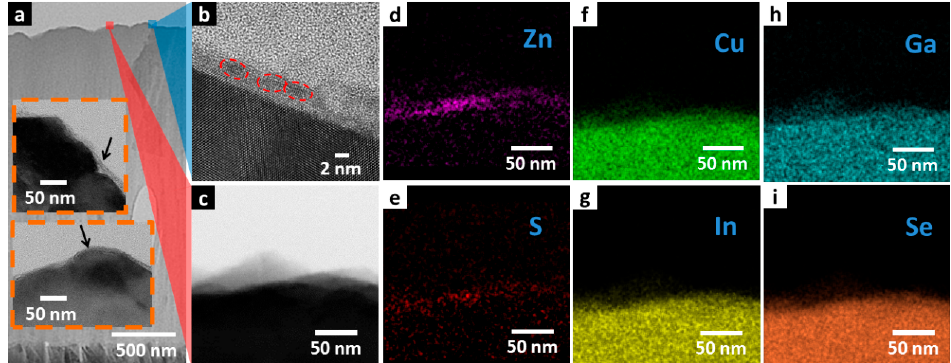
Figure 5. ( a ) TEM overview image of CIGS absorber layer capped by the ZnS NPs layer. Insets show magnified view at ZnS NPs/CIGS interface. ( b ) TEM image of ZnS NPs/CIGS pn junction magnified at individual ZnS NPs (indicated by the blue shade), in which single ZnS NPs are marked by red dashed circles. ( c ) TEM image of where energy dispersive spectrometer (EDS) mapping is conducted, indicated by the red shade, and EDS mapping of ( d ) Zn, ( e ) S, ( f ) Cu, ( g ) In, ( h ) Ga, and ( i ) Se.